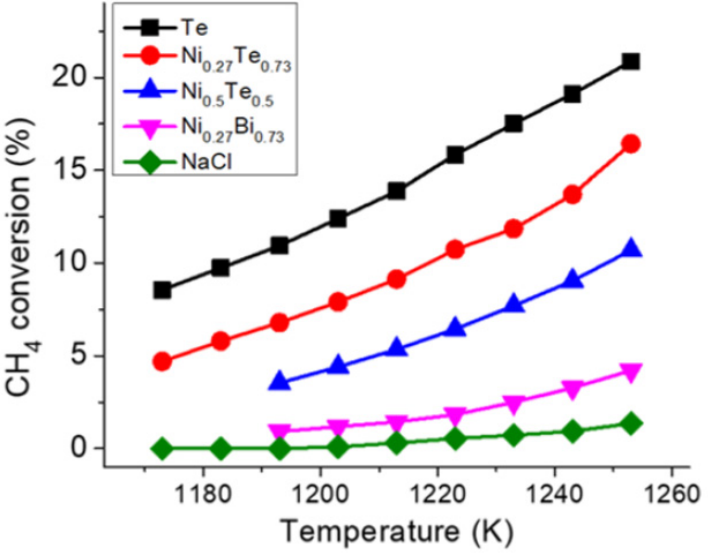
Figure 6. Methane conversion of pure Te compared with Ni–Bi and Ni–Te alloys, as well as with molten NaCl (Copied from Ref. [130] with American Chemical Society permission).